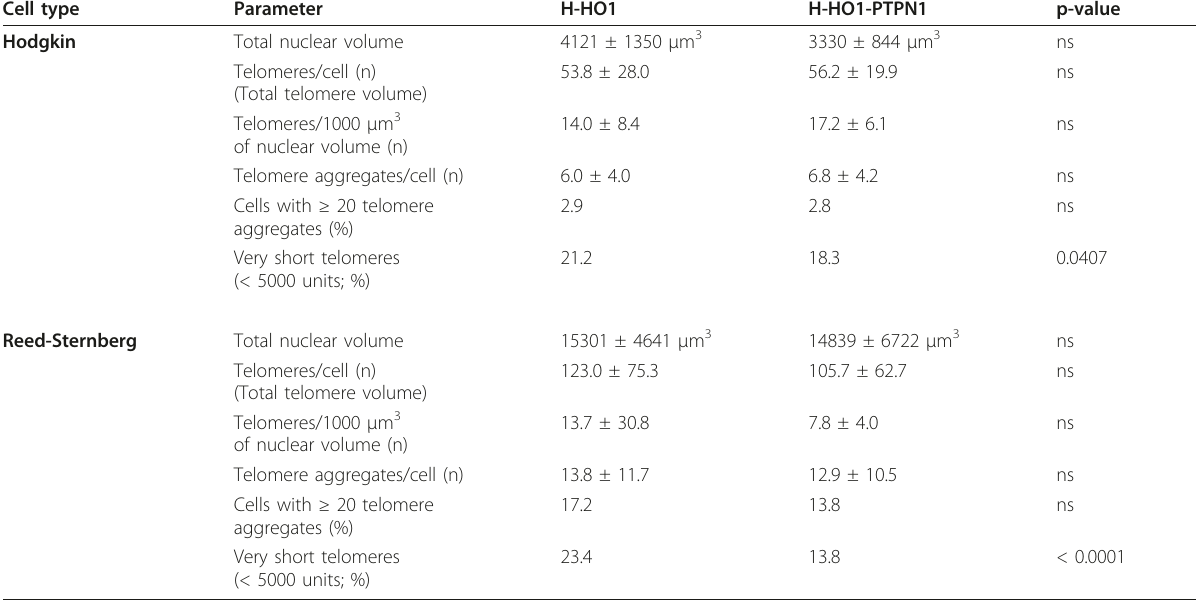
Table 1 3D telomere characteristics of Hodgkin and Reed-Sternberg cells in U-HO1 and U-HO1-PTPN1 Cell